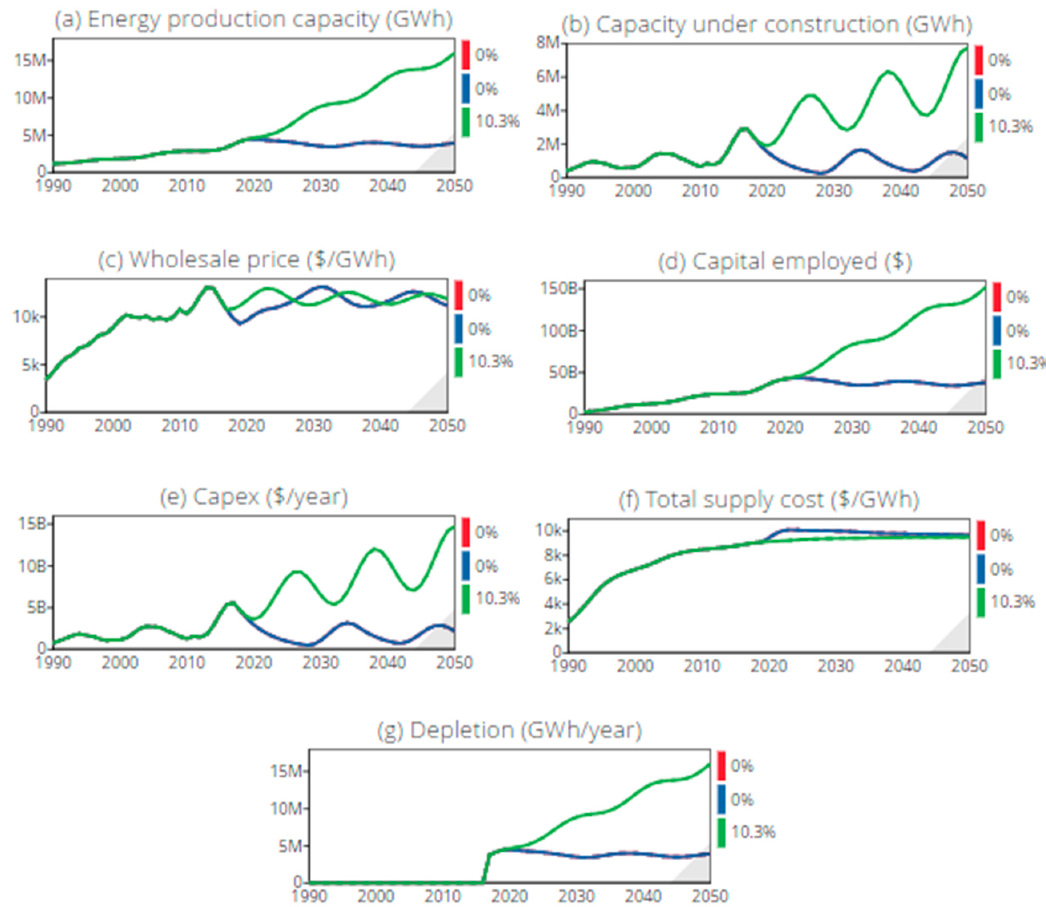
Figure 7. Extreme condition test results for black coal for ( a ) production capacity, ( b ) capacity under construction, ( c ) wholesale price, ( d ) capital employed, ( e ) capex, ( f ) total supply cost and ( g ) reserves depletion. The coloured lines on each graph represents (1) gross demand growth rate set to 0% (no growth), (2) base case scenario with gross demand growth rate set to 0% (current trend) per year for 2017 and (3) gross demand growth rate set to 10.3% (maximum).